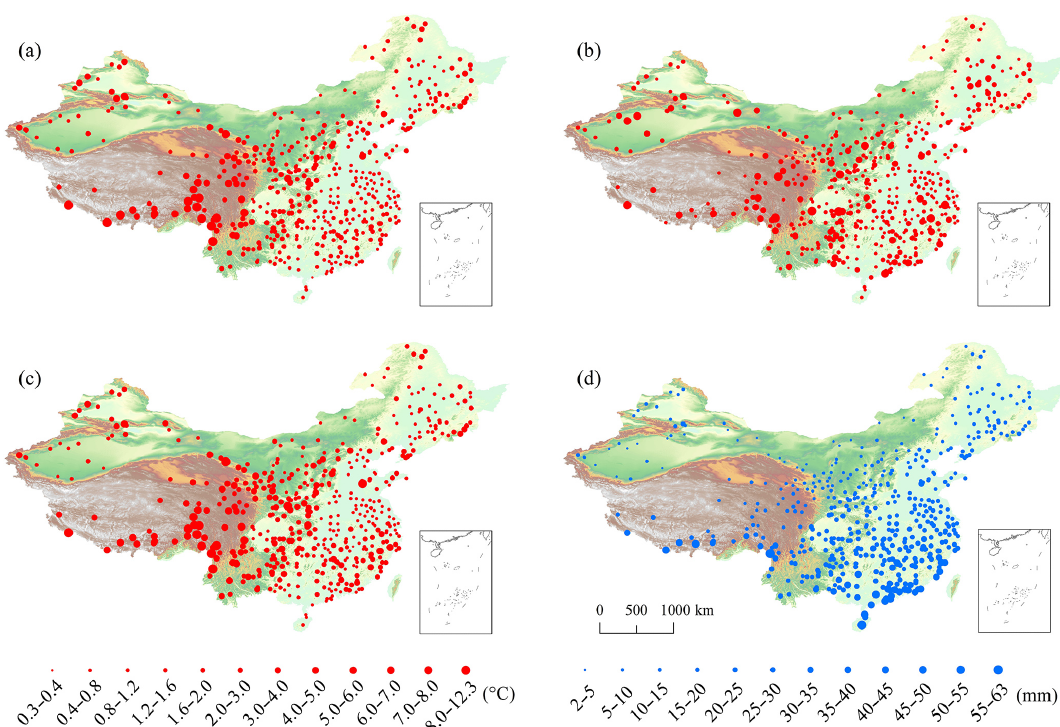
Figure 4. Spatial distribution of MAEs between the 30 (cid:48) original and observed TMPs–PRE from 1951 to 2016 at each independent weather station. Panels (a) – (d) show MAEs for the monthly minimum, mean, and maximum temperatures as well as the monthly precipitation,